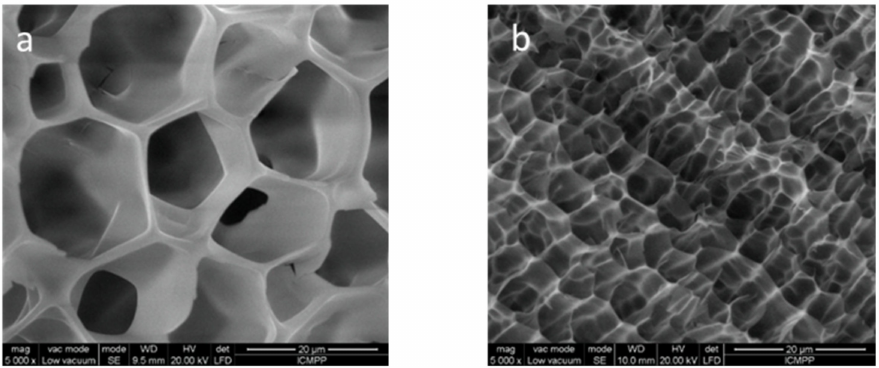
Figure 3. Representative SEM images of freeze–dried G4–CD_1 ( a ) and G4–CD_7 ( b ) hydrogels reflecting differences in pore size and wall